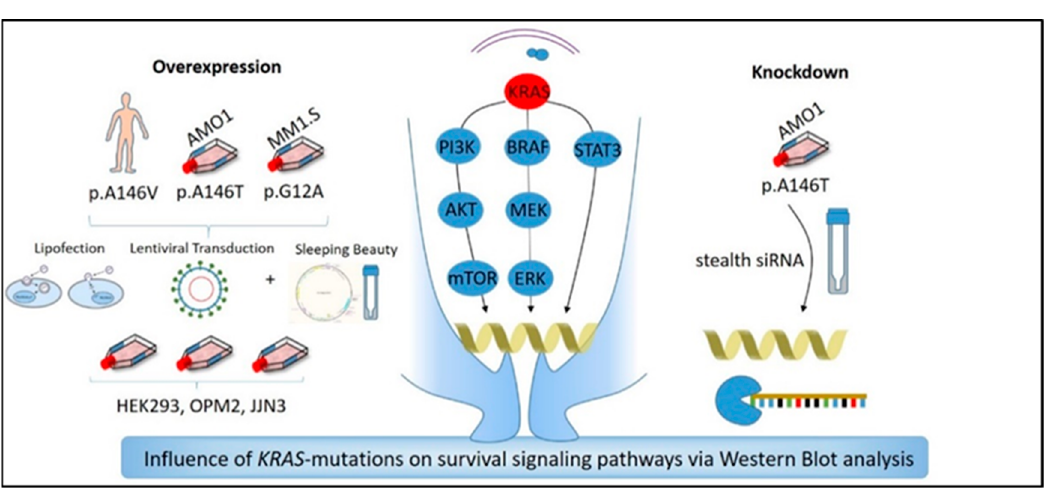
Figure 6. Experimental approaches to investigate the functional role of the KRAS exon-4 mutations